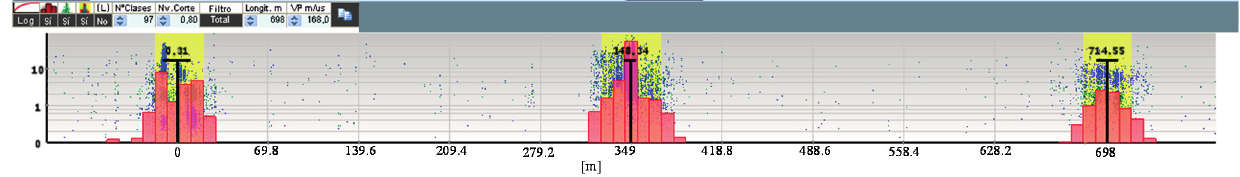
Figure 14. Example of pulse classification by location. PD sources located in different sites of a cable system.